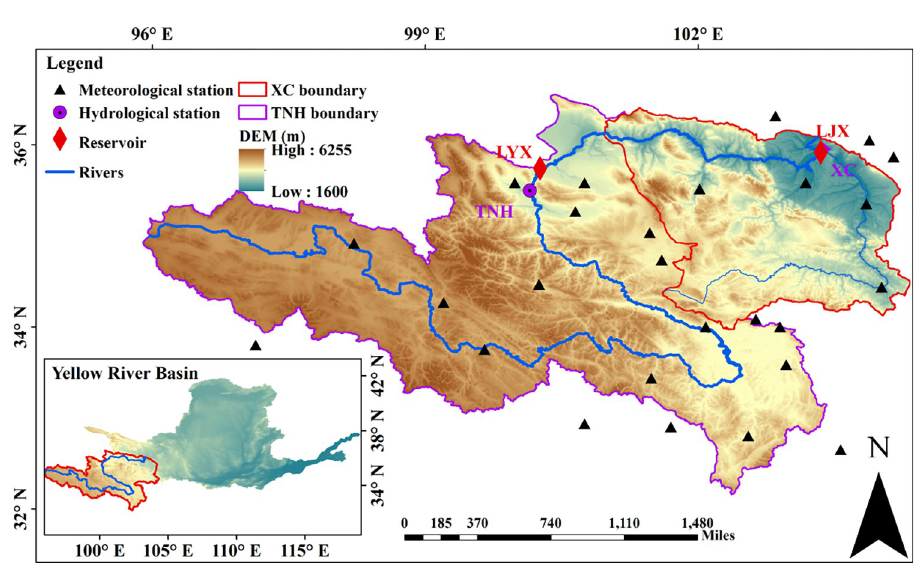
Fig 1. The geographical location and the spatial distribution of meteorological and hydrological stations.